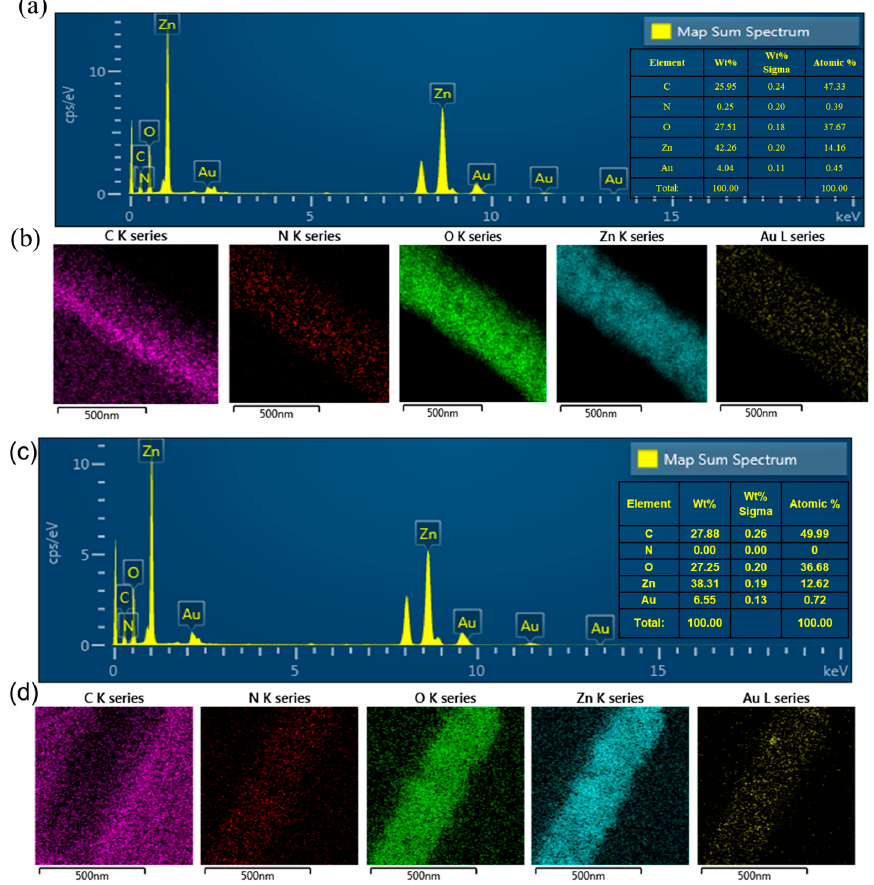
Figure 3. ( a ) EDS analysis (table in inset shows chemical analysis) and ( b ) EDS elemental mapping of Au-decorated ZnO-PANI (25 wt.%) composite nanofibers before gas sensing tests; ( c ) EDS analysis (table in inset shows chemical analysis); ( d ) EDS elemental mapping of Au-decorated ZnO-PANI (25 wt.%) composite nanofibers after gas sensing tests.